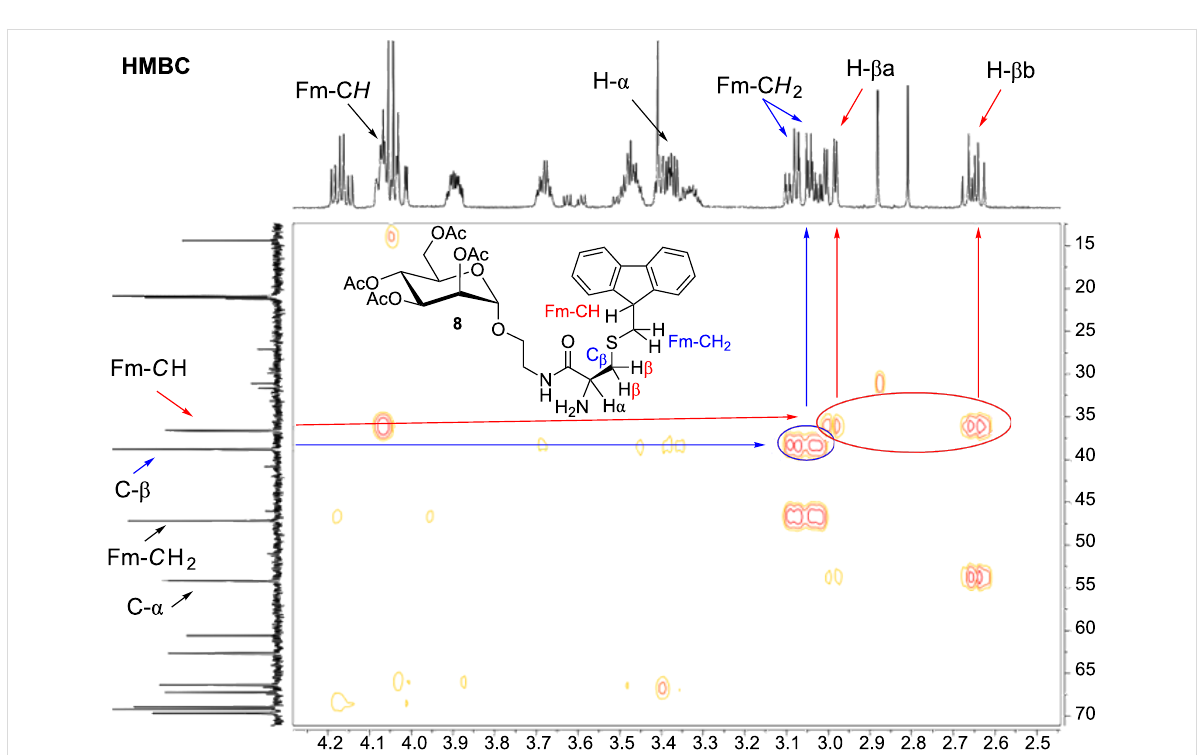
Figure 1: In the 1 H/ 13 C HMBC NMR spectrum of the S -Fm-protected glycoamino acid derivative 8 , protecting-group rearrangement is confirmed by the cross peaks between C- β and the Fm-C H 2 protons (in blue) and between Fm- C H and the H- β a, β protons (in